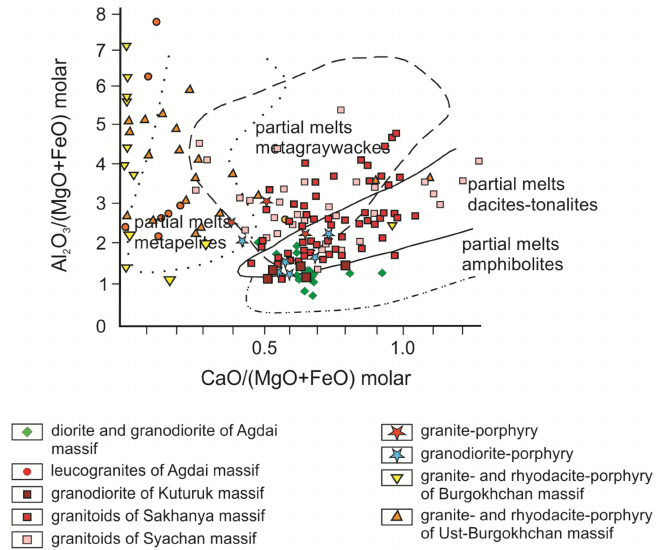
Figure 10. Magmogeneration substrates for igneous rocks of the Selennyakh River basin [45]. Granodiorites and granites of dikes are meta-aluminous (Schend index, 0.92–0.98), ferruginous (f = 66–84%), diopside-hypersthene normative, not containing normative corundum, with a predominance of normative albite (31–58%) over orthoclase (22–27%). Dl = 77–83%. The calculated magmogeneration temperatures are 907–931 ◦ C [36] at a pressure of 7–10 kbar, and the variations in crystallization temperatures—900–700 ◦